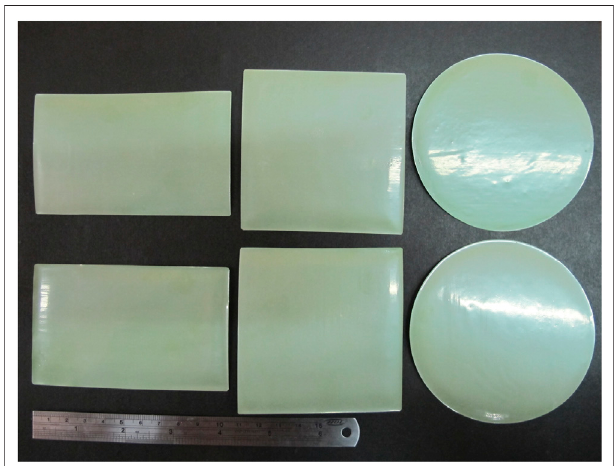
FIGURE 4 | Large half-cells with different shapes after sintering steps.